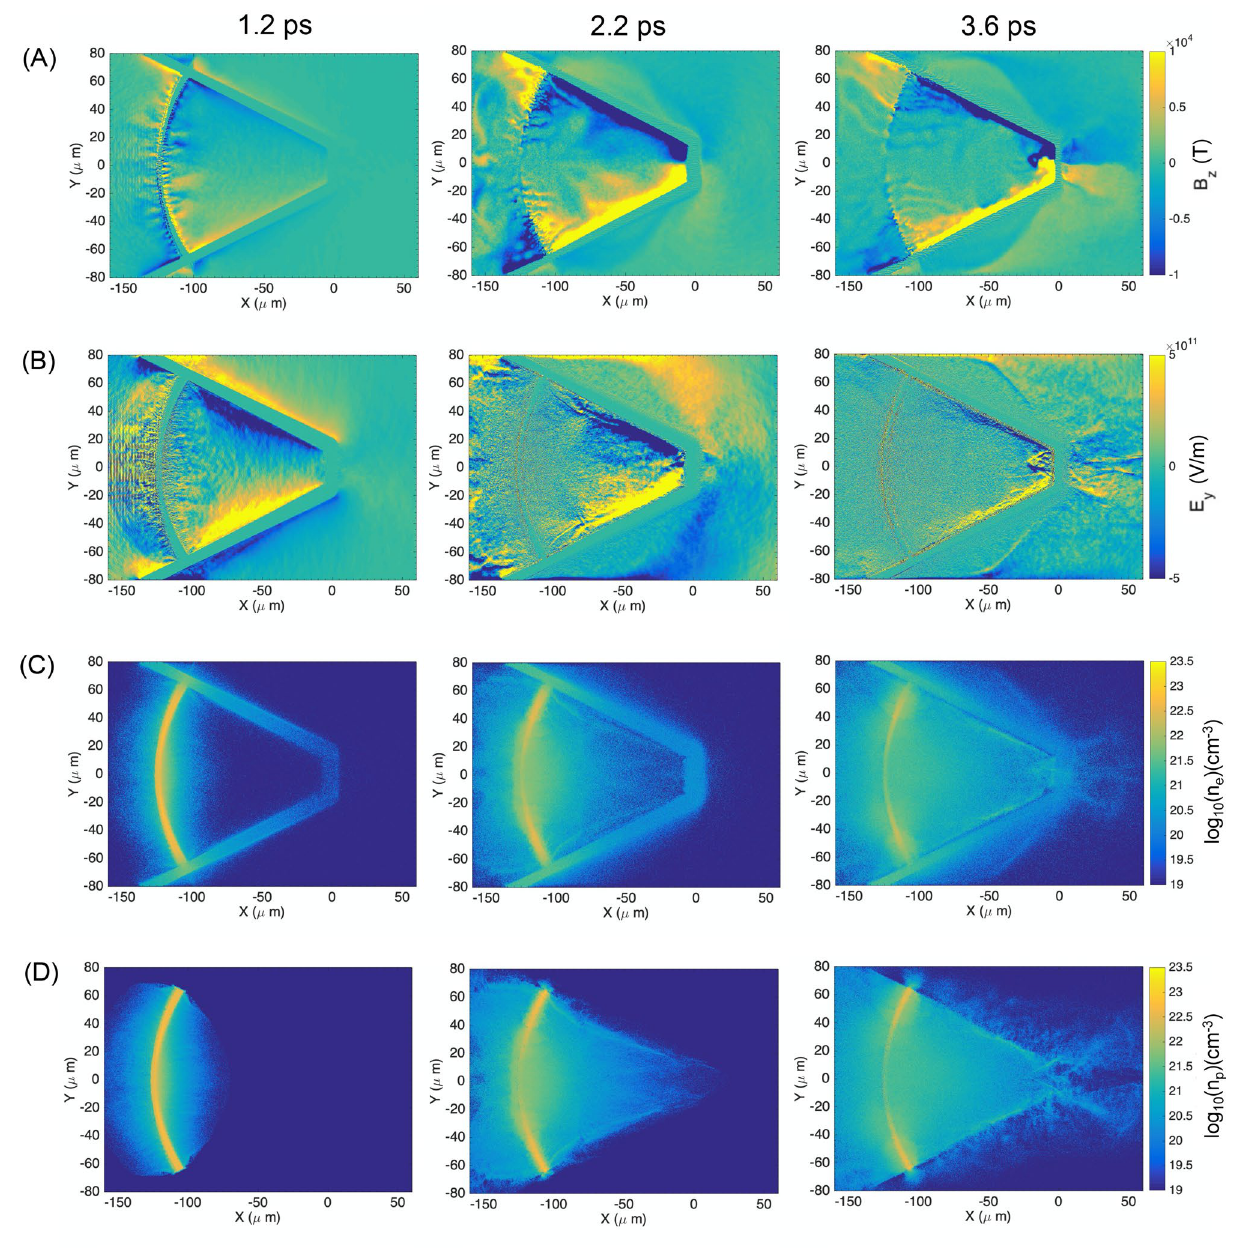
Figure 4. Bi-dimensional PIC simulations of proton beam generation and dynamics in free-standing cone target ( A ) Map of the Bz component of the magnetic field in the simulation for three simulation times: 1.2, 2.2 and 3.6 ps. At 1.2 ps, the surface current- generated magnetic field is initially distributed in the inner volume of the cone target. At later times it is compressed against the cone walls and tip by the expanding TNSA plasma, with magnetic field amplitude exceeding 10 kT and sharp gradients. ( B ) Map of the Ey component of the electric field for simulation times: 1.2, 2.2 and 3.6 ps. At early times the Ey component is produced mainly by fast electrons propagating along the cone walls. At intermediate times (not represented here) the electric field fades as the fast electron flow reduces. At 2.2 ps, when the TNSA plasma compresses the magnetic field inside the cone, a sudden strengthening of the electric field occurs due to the charge density gradient induced by the hot electron confinement by the magnetic field. Modulating the magnetic field gradients, the Ey component presents a de-collimating configuration that helps, together with the B-field, to deflect the proton beam exiting the cone. ( C ) Hot electron density map at 1.2, 2.2 and 3.6 ps simulation times. Only electrons coming from the hemi- shell are visualized in these maps. Initially the electron beam propagates and refluxes within the hemi-shell and the cone structure accelerating the proton beam via TNSA and generating focusing electric fields along the cone walls. At 2.2 ps as the TNSA plasma compresses the B-field, we can clearly observe the enhanced electron density in the area corresponding to the B-field gradients and the reduced electron density inside the B-field region. This is at the origin of the charge density gradient leading to the enhanced electric field in ( B ). This configuration is still clearly visible at 3.6 ps simulation time, with electrons accumulating at the edges of the magnetic field both on the cone walls and tip. ( D ) Hemi-shell proton density map at 1.2, 2.2 and 3.6 ps simulation time. At 1.2 ps we observe the protons being accelerated at the front and rear side of the hemi-shell. At later times, as the proton beam propagates inside the cone, we can clearly appreciate the focusing effect of the Ey component at 2.2 ps. At 3.6 ps, the proton beam is being deflected at the cone tip by the combined action of the Ey and Bz components, ultimately resulting in ring-like spatial distribution with large divergence angle, as observed in the experimental